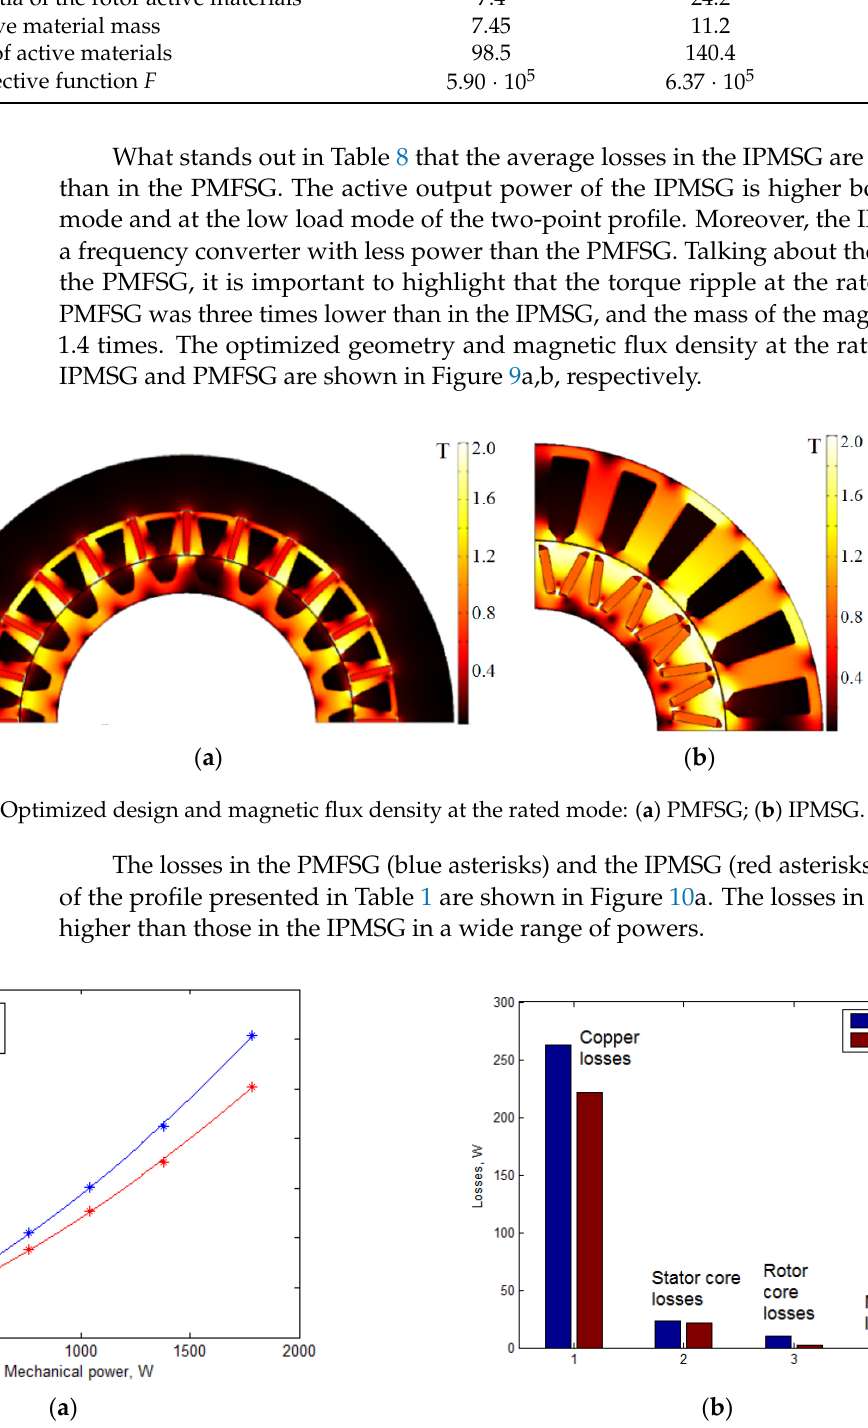
Figure 10. Comparative dependencies: ( a ) dependence of total losses on mechanical power of PMFSG and IPMSG; ( b ) electric losses of PMFSG and IPMSG at the rated conditions.